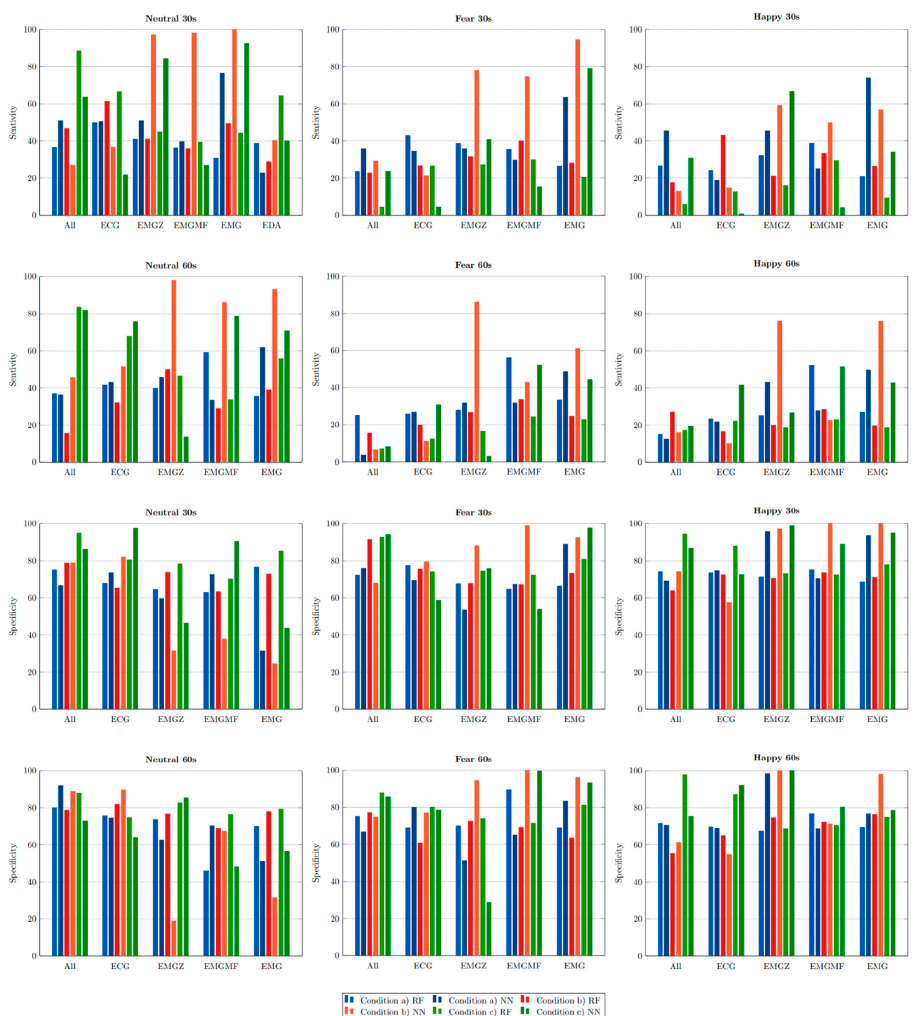
Figure 5. Sensitivity and specificity obtained for the two classifiers in different condition; ( a ) corresponds to the subject independent evaluation, ( b ) corresponds to the subject dependent evaluation, and ( c ) corresponds to emotion dependent evaluation.